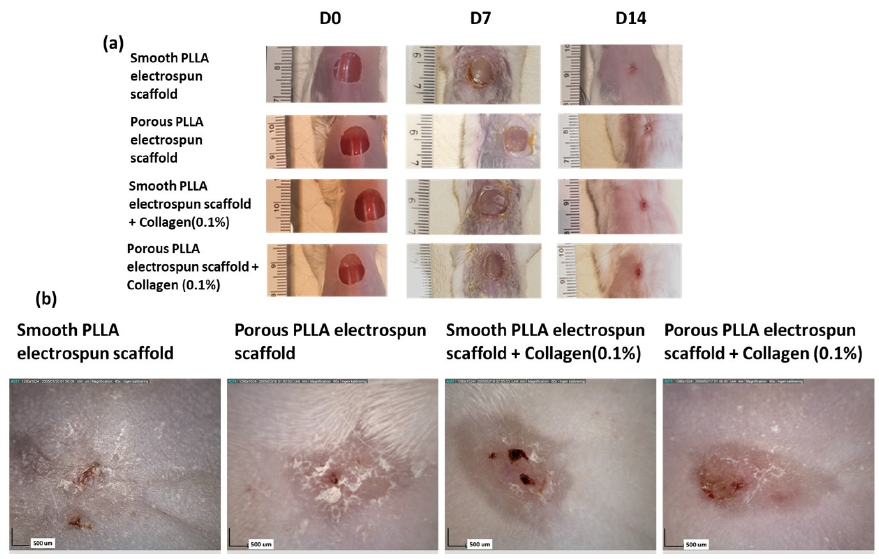
Figure 2. Macroscopic wound assessment following treatment with unmodified or collagen ‐ func ‐ tionalized smooth and porous PLLA scaffolds. ( a ) Representative images of wounds from the study groups: smooth PLLA electrospun scaffold, porous PLLA electrospun scaffold, smooth PLLA elec ‐ trospun scaffold + collagen (0.1%) and porous PLLA electrospun scaffold + collagen (0.1%) at day 0, 7, and 14 (all images include a ruler with small graduations of 1 mm). ( b ) Wounds were also imaged under Dermascope at day 14 (scale bar 500 μ m).